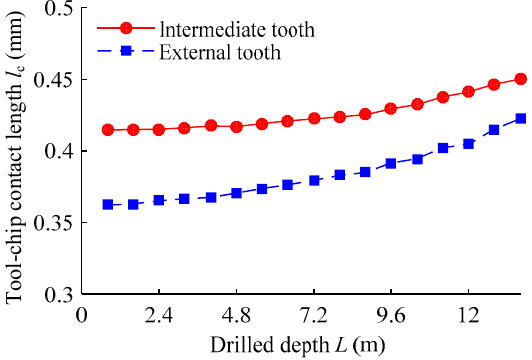
Figure 13. Effect of the drilling process parameters on the tool-chip contact length: ( a ) under different drilling feeds at a speed of 1200 r/min; ( b ) under different drilling speeds at a feed of 0.1 mm/r.